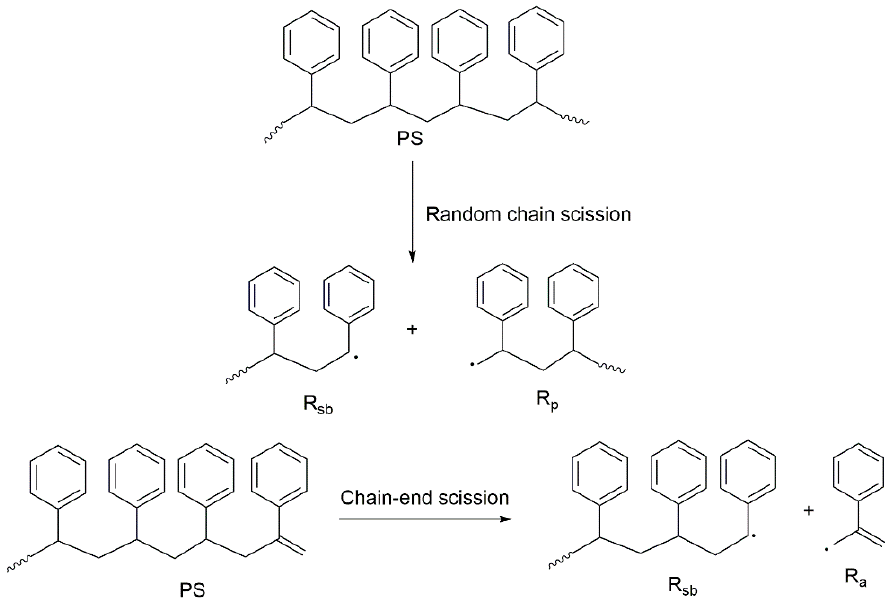
Figure 5. A schematic representation of initiation during the thermal decomposition of PS [36,42].